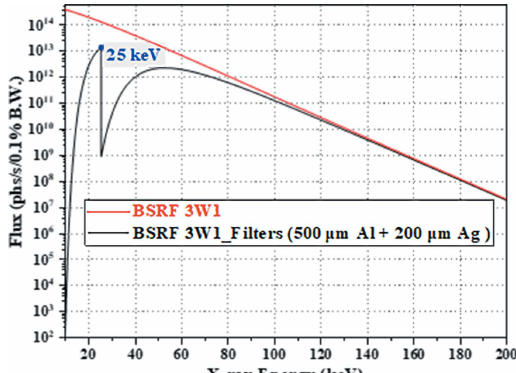
Figure 6 A special case where the micro-scanning method fails. The vertical position of the micro-scan was intentionally staggered for clear observation.